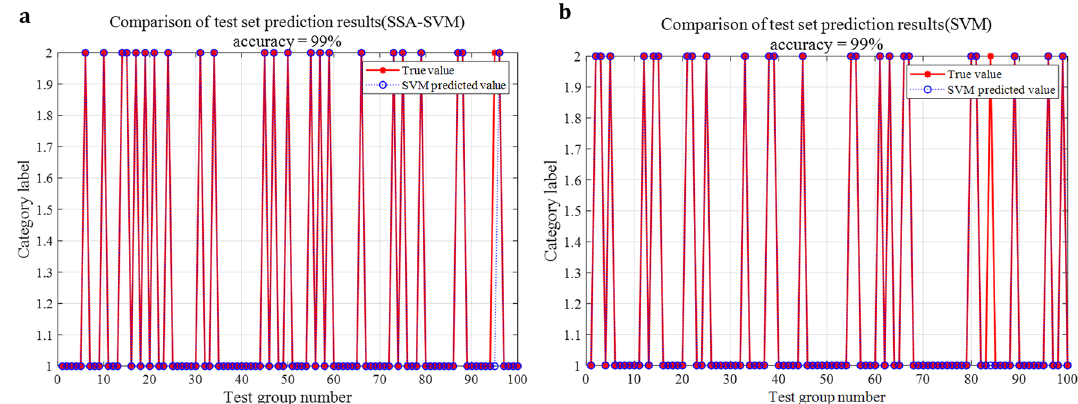
Figure 14. Fault diagnosis accuracy of SSA-SVM and CV-SVM. ( a ) Fault diagnosis accuracy of SSA-SVM. ( b ) Fault diagnosis accuracy of CV-SVM.